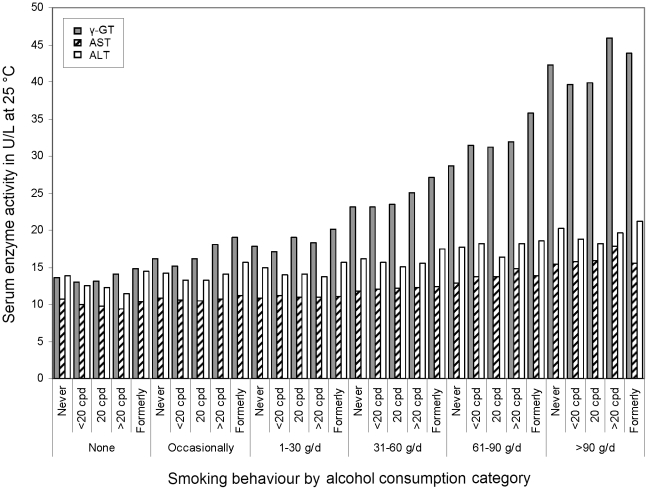
Geometric mean serum activities of γ-GT (grey bars), AST (hatched bars) and ALT (white bars; all in U/L measured at 25°C) in 15,281 men in Germany, by alcohol consumption intensity (bottom row) and smoking behaviour (cpd = cigarettes per day).